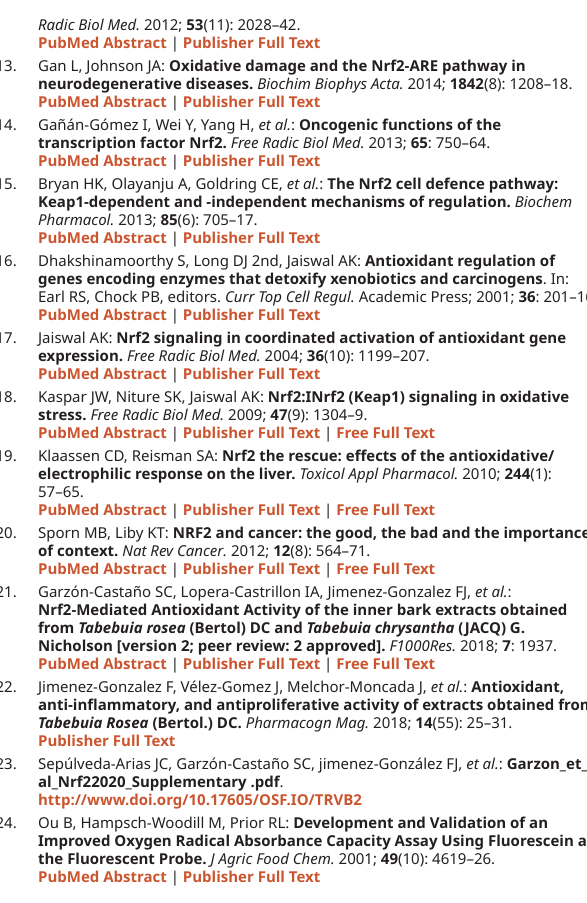
Figure 4.csv - Dataset 4 Relative HMOX-1 and NQO1 mRNA levels Figure 5.csv - Dataset 5 Relative HMOX-1 and NQO1 mRNA levels Figure 6.csv Extended data Open Science Framework: Garzon_et_al_Nrf22020_Supplemen- tary .pdf. https://doi.org/10.17605/OSF.IO/TRVB2 23